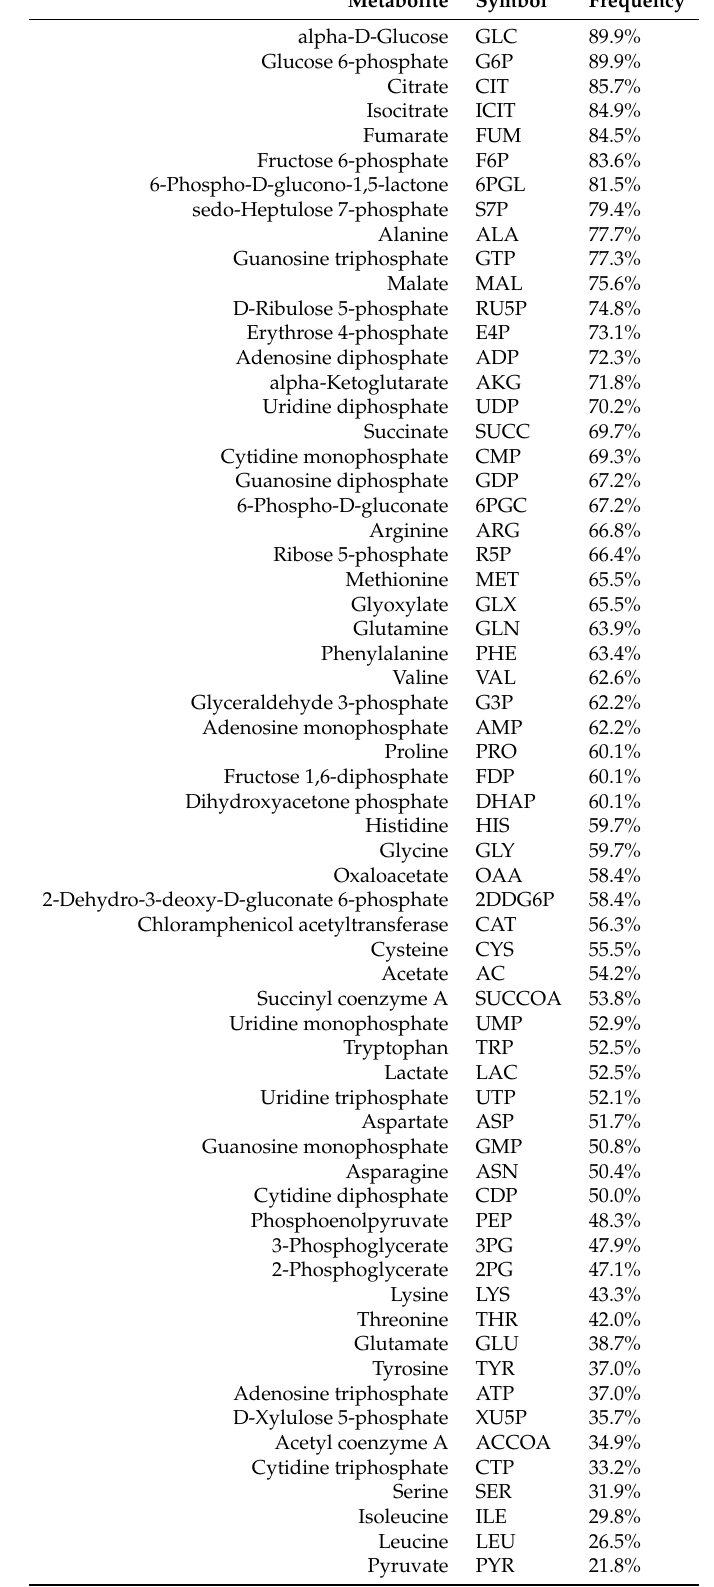
Table 4. Metabolites by frequency of appearance in the simulated annealing constraint